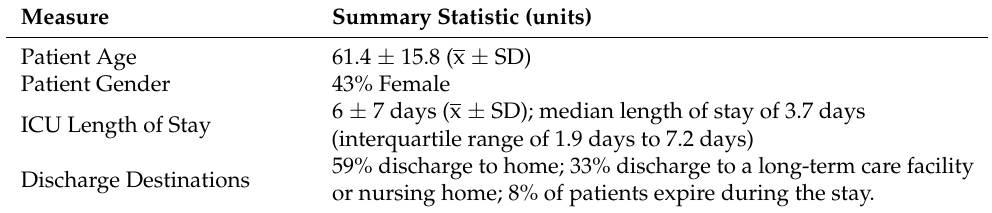
Table 3. Study sample summary statistics.